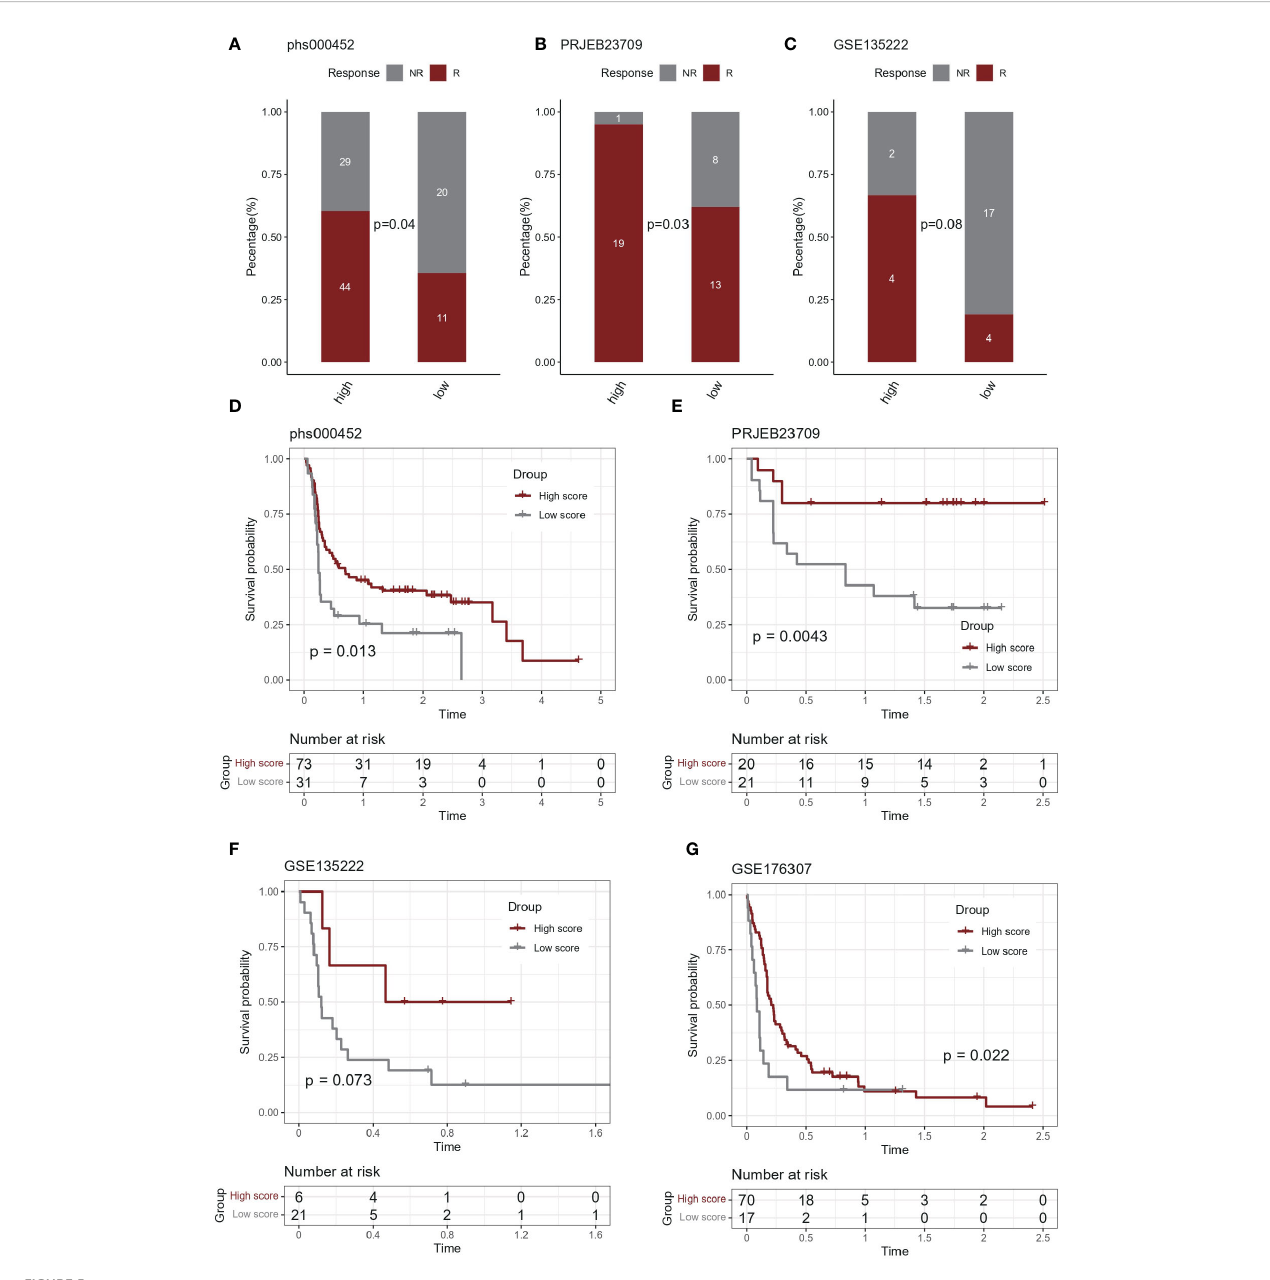
FIGURE 5 Predictive effect of IL-1score in immunotherapy. (A-C) In the immunotherapy cohort, IL-1score showed discriminatory ability for immunotherapy ef fi cacy. (D-G) In terms of survival, the group with high IL-1score showed an advantage in progression-free